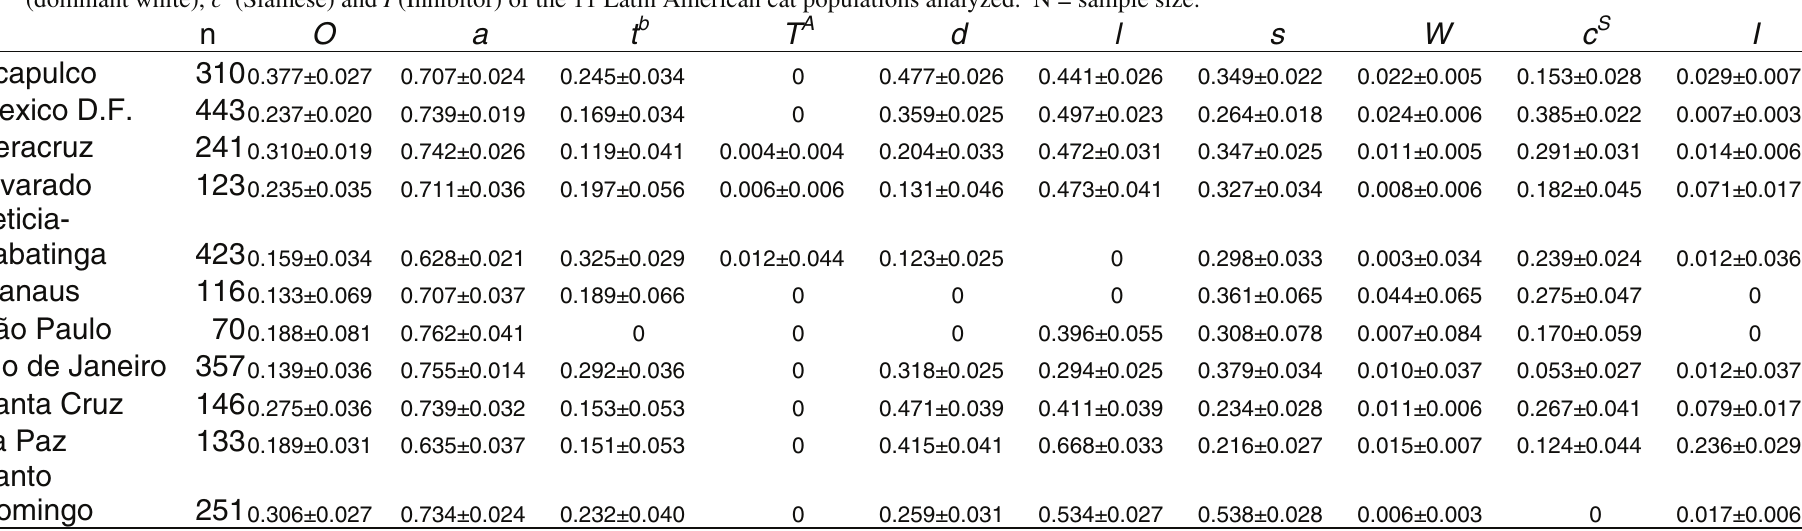
Table S1. Allele frequencies and standard deviations of O (Orange), a (non-agouti), t b (blotched tabby), T A (Abyssinian tabby), d (dilution), l (long hair), S (white spotting), W (dominant white), c s (Siamese) and I (Inhibitor) of the 11 Latin American cat populations analyzed. N = sample